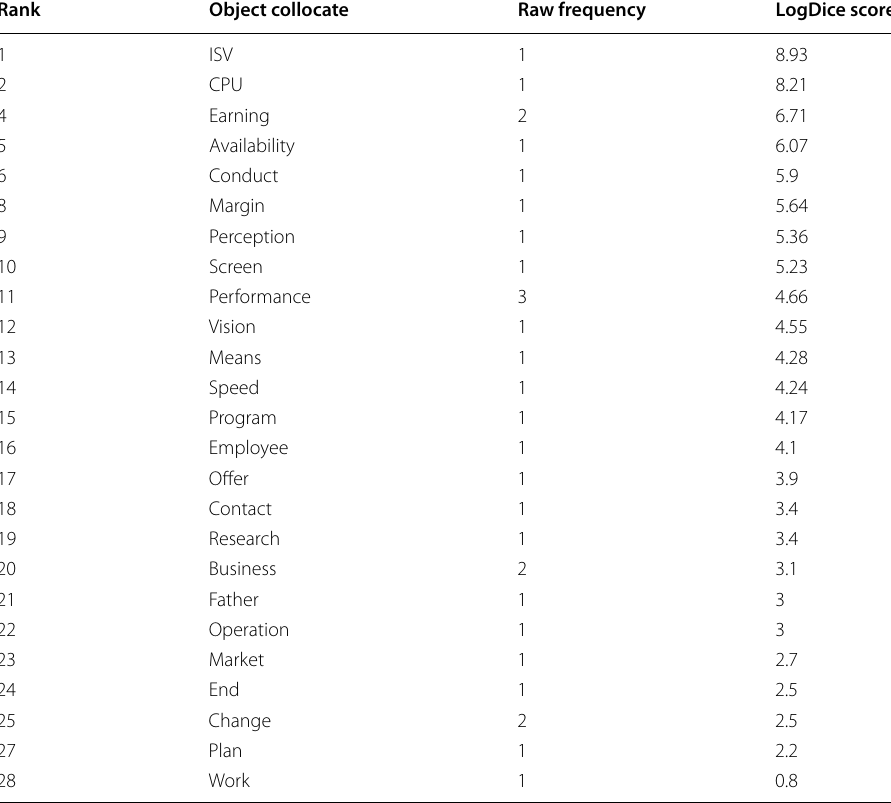
Table 12 Object collocates of